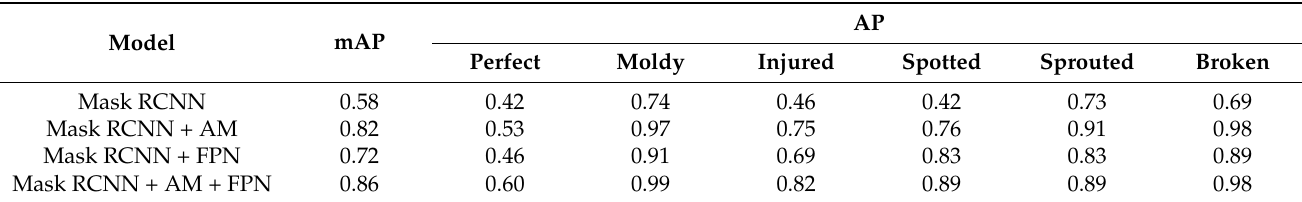
Table 3. AP values of different kernels under different models in validation.